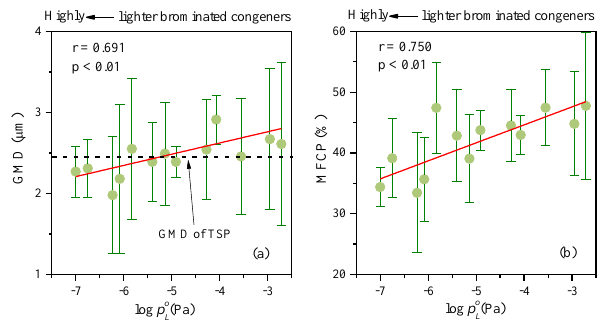
Figure 4. Pearson correlation between GMD and log p ◦ ticulate PBDEs (left) as well as between mass fractions of PBDE congeners in coarse-size particles (MFCP) and log p ◦